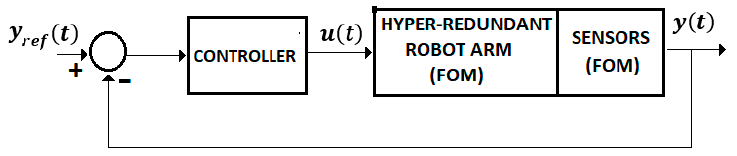
Figure 14. Control system with FOM sensors.